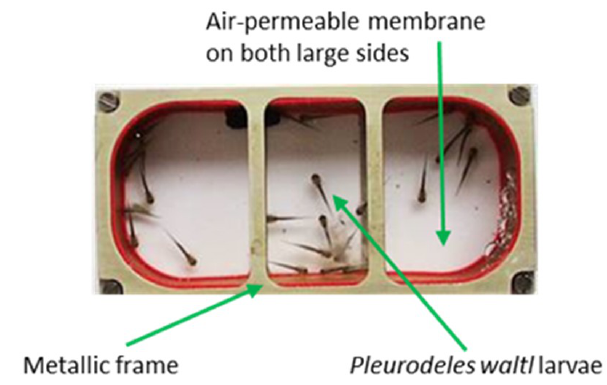
Figure 1. Miniaquarium developed by EADS (European aeronautic defense and space company)-Astrium and the German Space Agency to allow amphibian embryo development onboard the international space station (ISS). These miniaquaria measure 80 mm in length by 40 mm in width and 20 mm in height, and have two transparent sides that are permeable to O 2 and CO 2 . Once in the ISS, these miniaquaria are placed in the Kubik incubator to maintain temperature at 20 °C.